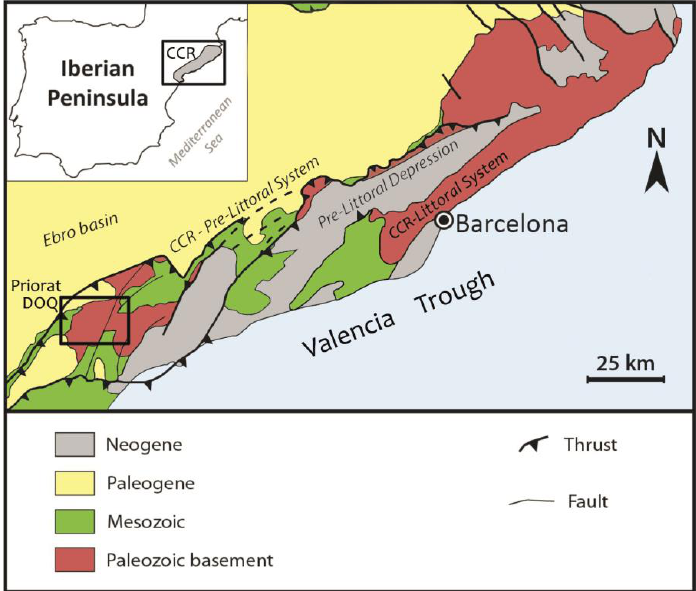
Figure 1. Tectonic setting of the Priorat DOQ region on the northeastern coast of the Iberian Peninsula. Geologic units and general tectonic outline of the Catalan Coastal Ranges are modified from [34]. All samples used in this study were collected from natural outcrops and road cuts (Figure 2) along the highways connecting Gratallops, El Lloar, Torroja del Priorat, El Molar, La Vilella Baixa and La Cartuja De Escaladei. Paleozoic black shale (principal